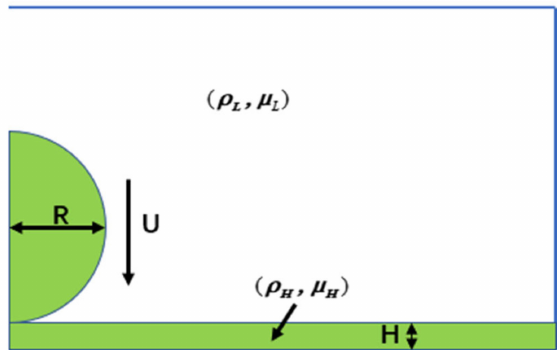
Figure 19. Illustration of the droplet splashing on a thin film.